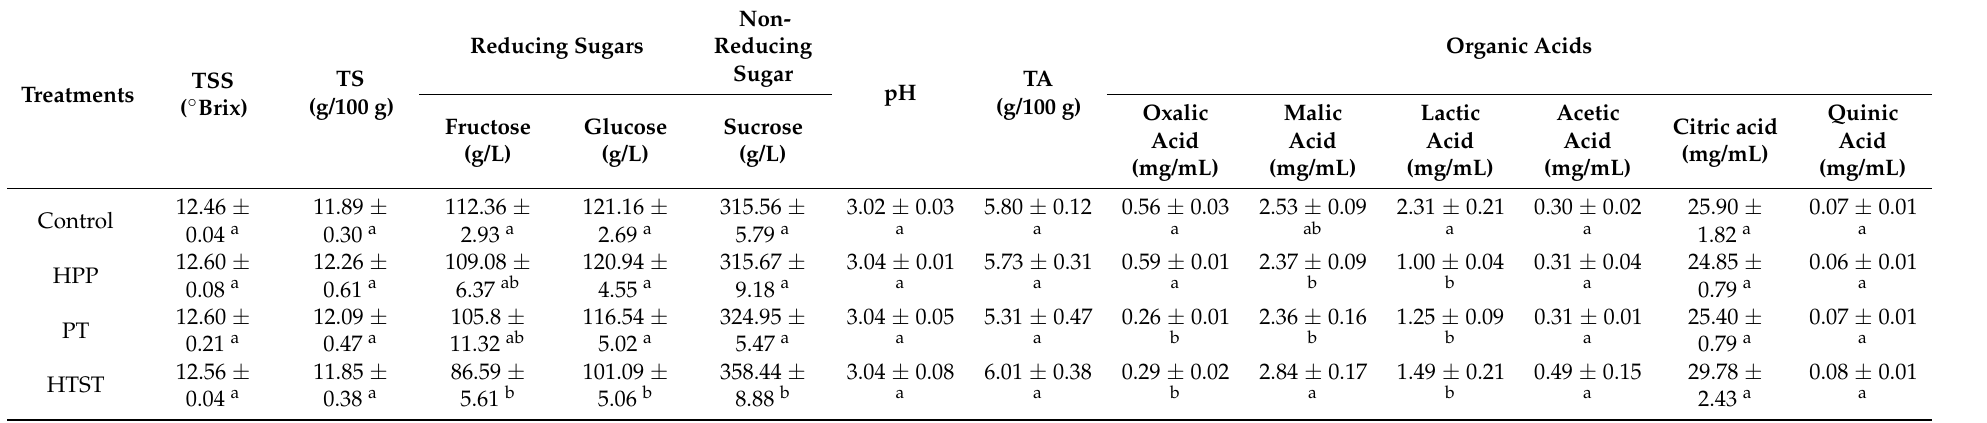
Table 2. Effect of high-pressure processing (HPP), pasteurization (PT), and high-temperature short time (HTST) on taste-related attributes (sugar and organic acid) of passion fruit pur é